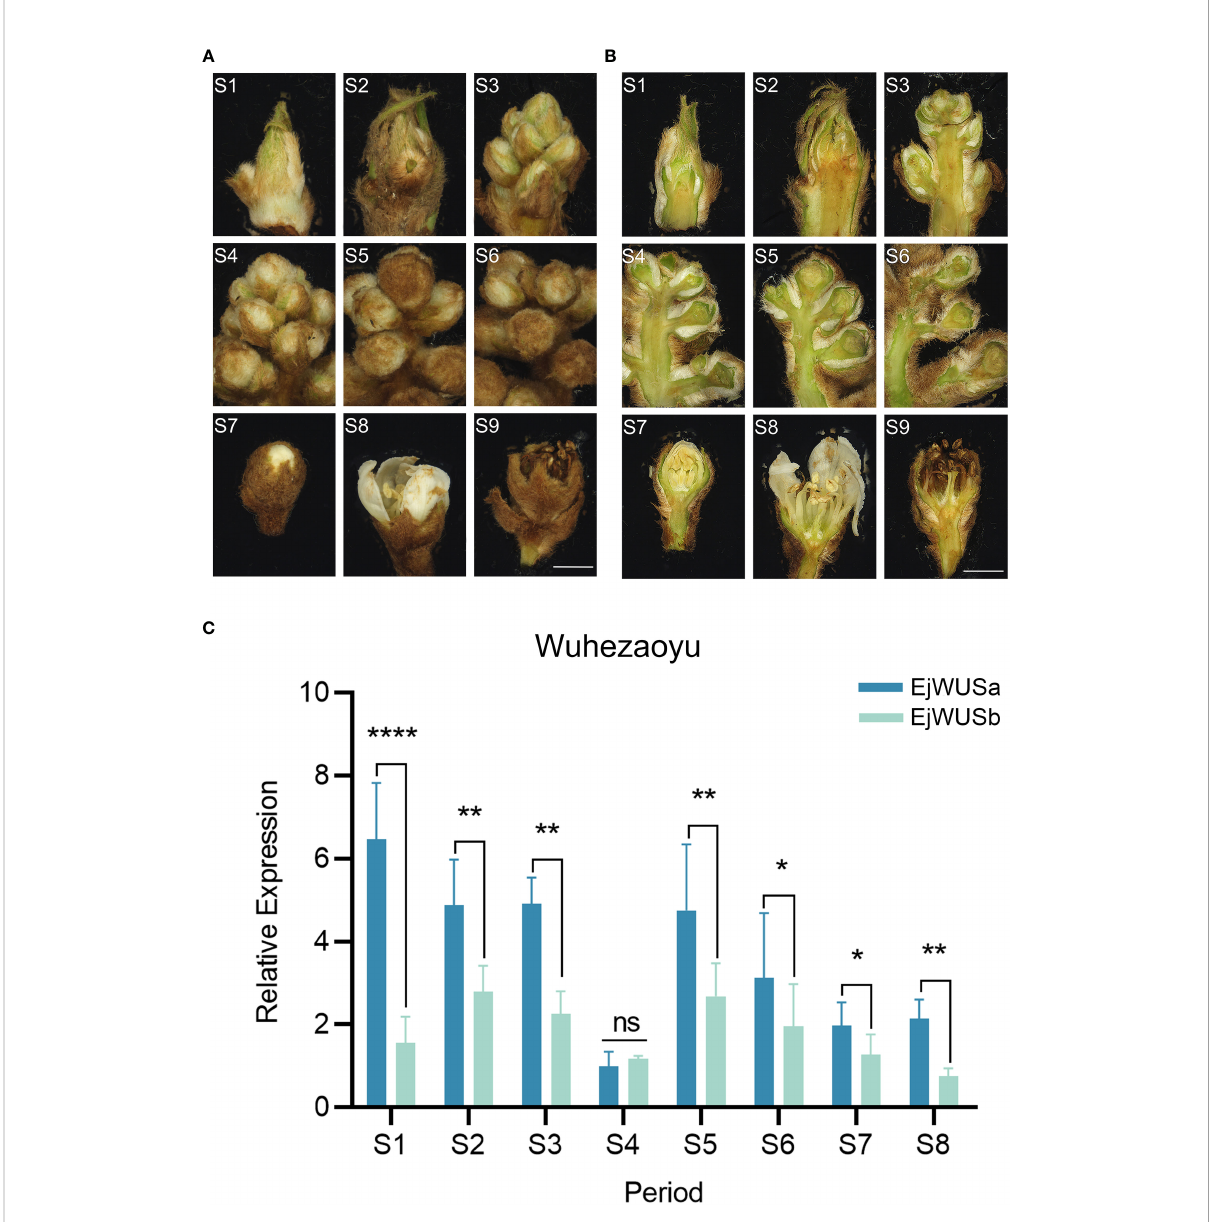
FIGURE 5 In fl orescence morphology and morphological anatomy of the triploid loquat ‘ Wuhezaoyu ’ and the temporal expression patterns of EjWUSa and EjWUSb in the triploid loquat ‘ Wuhezaoyu ’ fl ower buds. (A, B) In fl orescence morphology and morphological anatomy of the triploid loquat ‘ Wuhezaoyu ’ . S1: Vegetative apex; S2: Floral meristem initiation and fl ower bud differentiation; S3: Rapid differentiation of fl oral buds; S4: Panicle elongation; S5: Floral bud elongation with visible fl oral buds; S6: Elongation of branches in a panicle; S7: White corollas of fl oral buds; S8: Floral anthesis and full bloom; S9: Petal fall. Bars = 2000µm. (C) The temporal expression patterns of EjWUSa and EjWUSb in the triploid loquat ‘ Wuhezaoyu ’ fl ower buds. Ejactin as an internal control. Error bars indicate Standard Error (SE) from three biological replicates. Asterisks or n.s. indicate signi fi cant differences between EjWUSa and EjWUSb , *p<0.05, **p<0,01, **** P < 0.0001, ns, no signi fi cant difference, by One-way